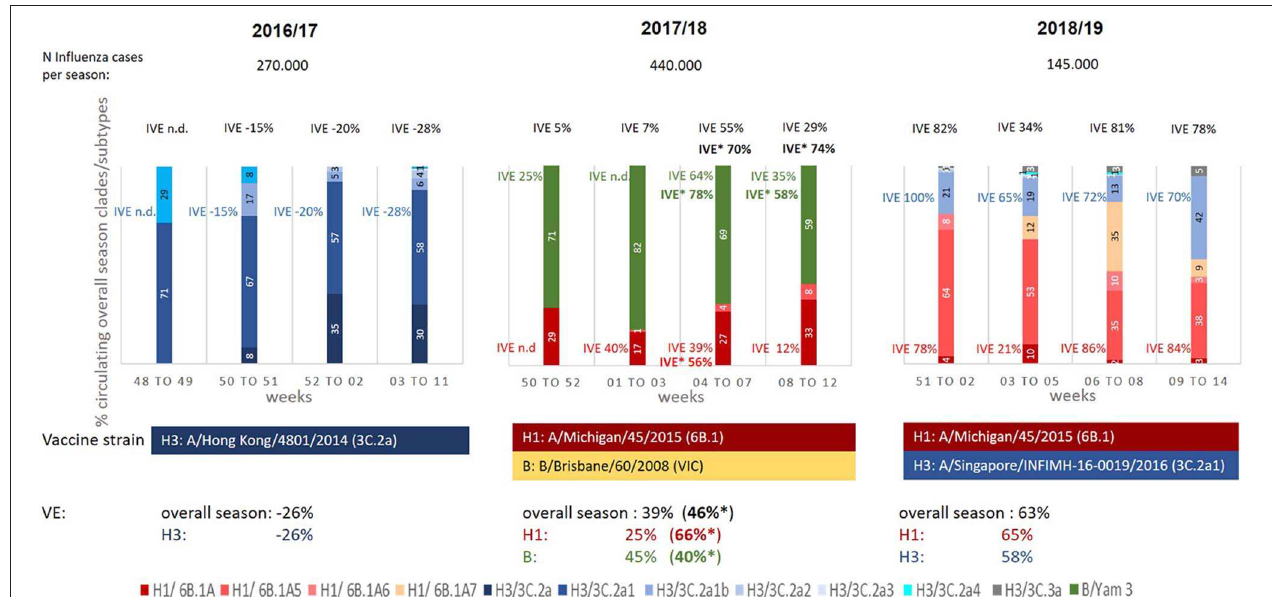
FIGURE 2 | Proportion (%) of circulating influenza virus genetic subclades during seasons 2016/17 to 2018/19; Black: IVE overall, blue: IVE against influenza A(H3N2), red: IVE against influenza A(H1N1)pdm09, green: IVE against Influenza B (aTIV/TIV/QIV and LAIV), bold*: IVEs using quadrivalent vaccines (QIV/LAIV) (Season 2017/18); n.d., not done due to low case